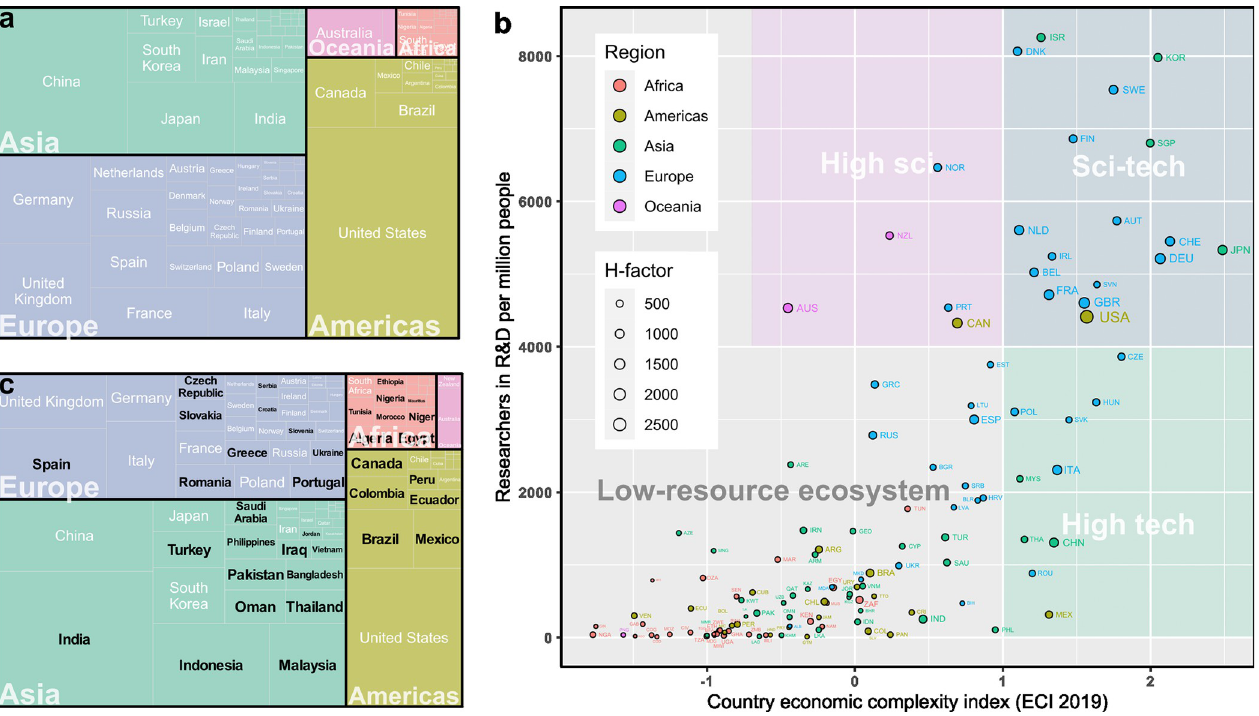
Fig 1. Publication statistics reveal global trends in DIY technology use. ( a) The global distribution of total publications produced by countries and regions. A country’s fraction of total publications (58,485,740) is represented by its relative size in the graph. Data source: scimagojr total citable documents on any topic from 1996 to 2020. ( b) Graph showing each country (marked by country code and colored by region) with respect to their density of researchers in the population and their economic complexity index. The size of the points represents the country’s H-index. Data sources: researcher density, Worldbank Development Indicators, latest data available by country; economic complexity index, Atlas of Economic Complexity, 2019 data or latest available; country H- index, scimagojr country rank, 1996–2020 all subjects; global regions, UN sustainable development goals. Countries AU : Pleasecheckandconfirmthattheedittothesentence } Countrieswithoutdatainallrelevantdatasetswereremoved : } didnotaltertheintendedthoughtofthesentence : without data in all relevant datasets were removed. ( c) Global distribution of publications that mention the tools “Raspberry Pi” or “Arduino” in the method section of the article by country and regions. A country’s fraction of total publications (3,718) is represented by its relative size in the graph. Countries visibly overrepresented in this category relative to overall publications are highlighted in black. Data source: Web of Science (WoS) search results on “Raspberry Pi” or “Arduino” across publications (articles, proceedings papers, early access, and data papers) indexed before the search date (15 September 2022). A total of 13,285 articles were found. This publication dataset was then compared to a Scite search on wider literature with “Arduino” or “Raspberry Pi” in the method section (23,703 results). The datasets were then merged by DOI and, where absent, by title to obtain 3,718 matches that contain the WoS publication type filter, method section criterion, and publication country data. The relative publication by country distribution for all WoS articles on the topic is similar to the result displayed for the method section only. The R code to generate Fig 1 is shared in the following repository: